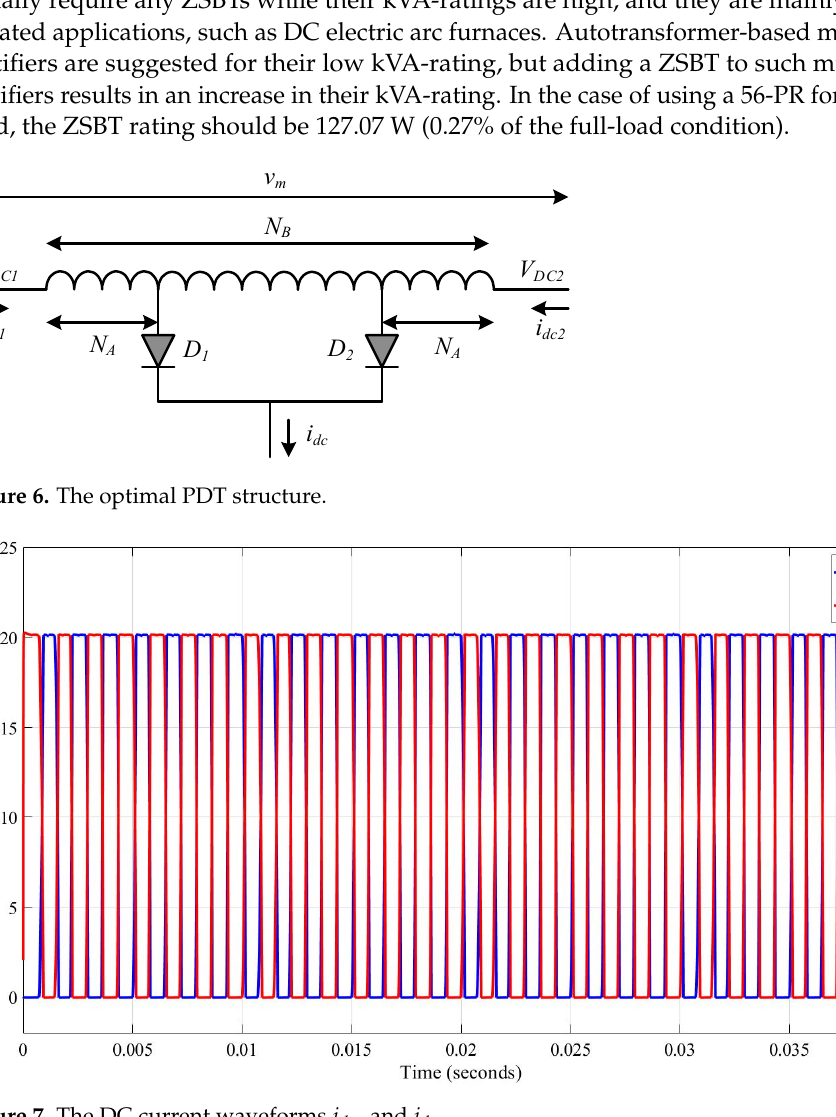
and 𝑖 (cid:3031)(cid:3030) and 𝑖 (cid:3031)(cid:3030) . (cid:3117) (cid:3118) (cid:3117) (cid:3118)